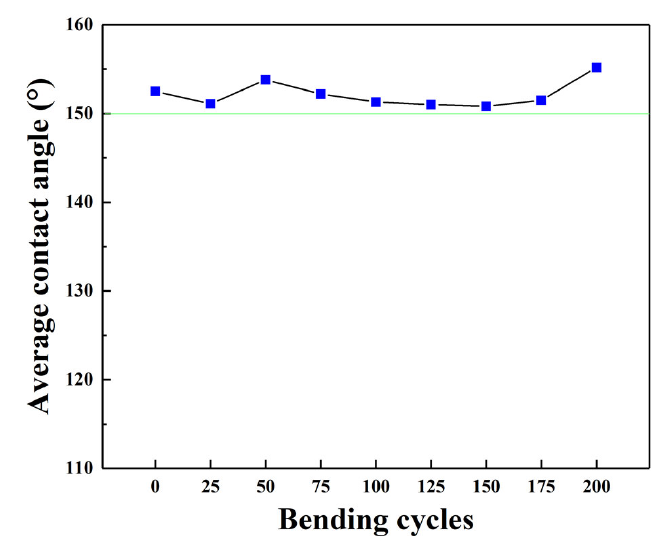
Figure 7. Average CA for different bending cycles.